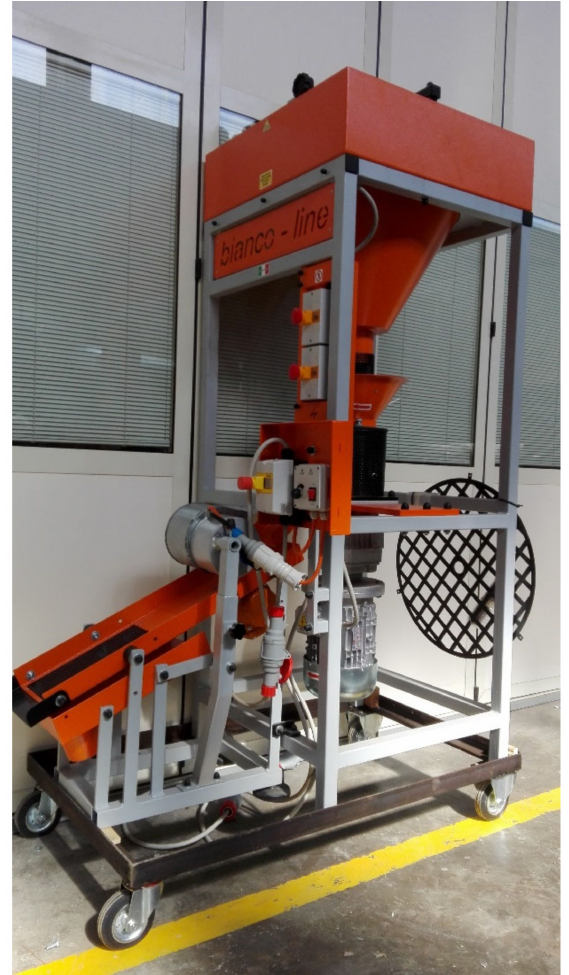
Figure 1. Pellet machine utilized for the